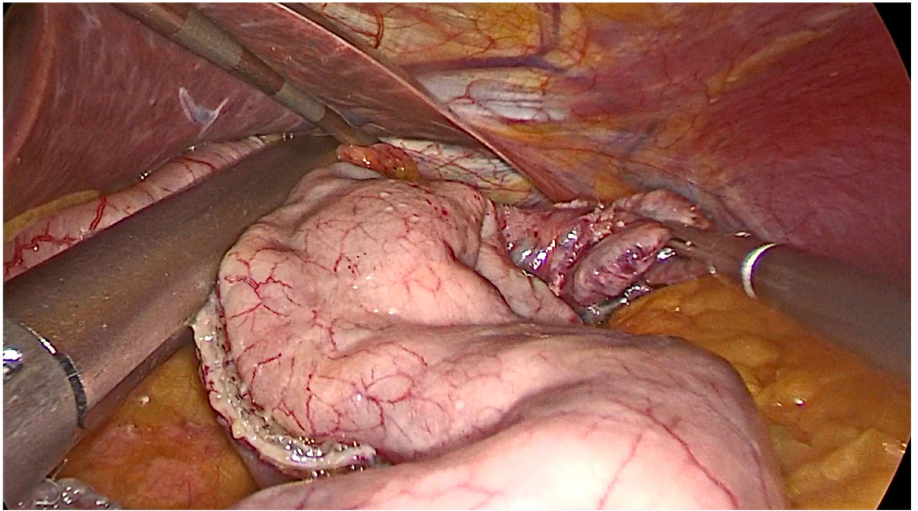
Figure 3. Intraoperative image of sleeve gastrectomy with concomitant resection of the